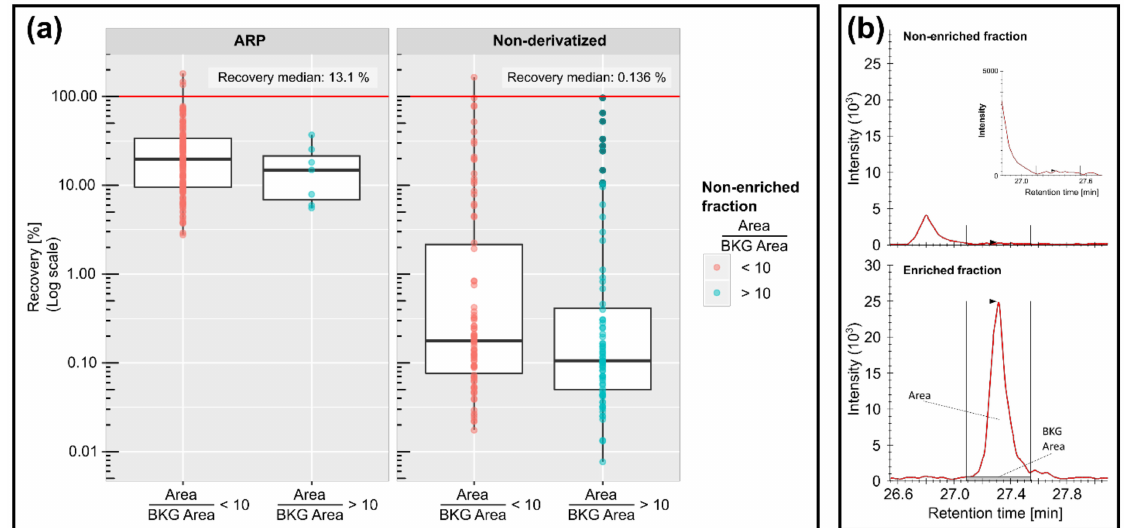
Figure 3. Box blots for the recovery rates of ARP and non-ARP-derivatized peptides ( a ) and extracted ion chromatograms (XICs) of the triply protonated ARP-labelled HSA peptide YIC[+57.022]ENQDSISSK[+312.089]LK at m / z 666.308 before (top) and after enrichment (bottom) by affinity chromatography ( b ). The recovery rates were grouped by area-to-background area (A/B) ratios in non-enriched fractions of below 10 (red) and above 10 (turquoise), presumably allowing a good